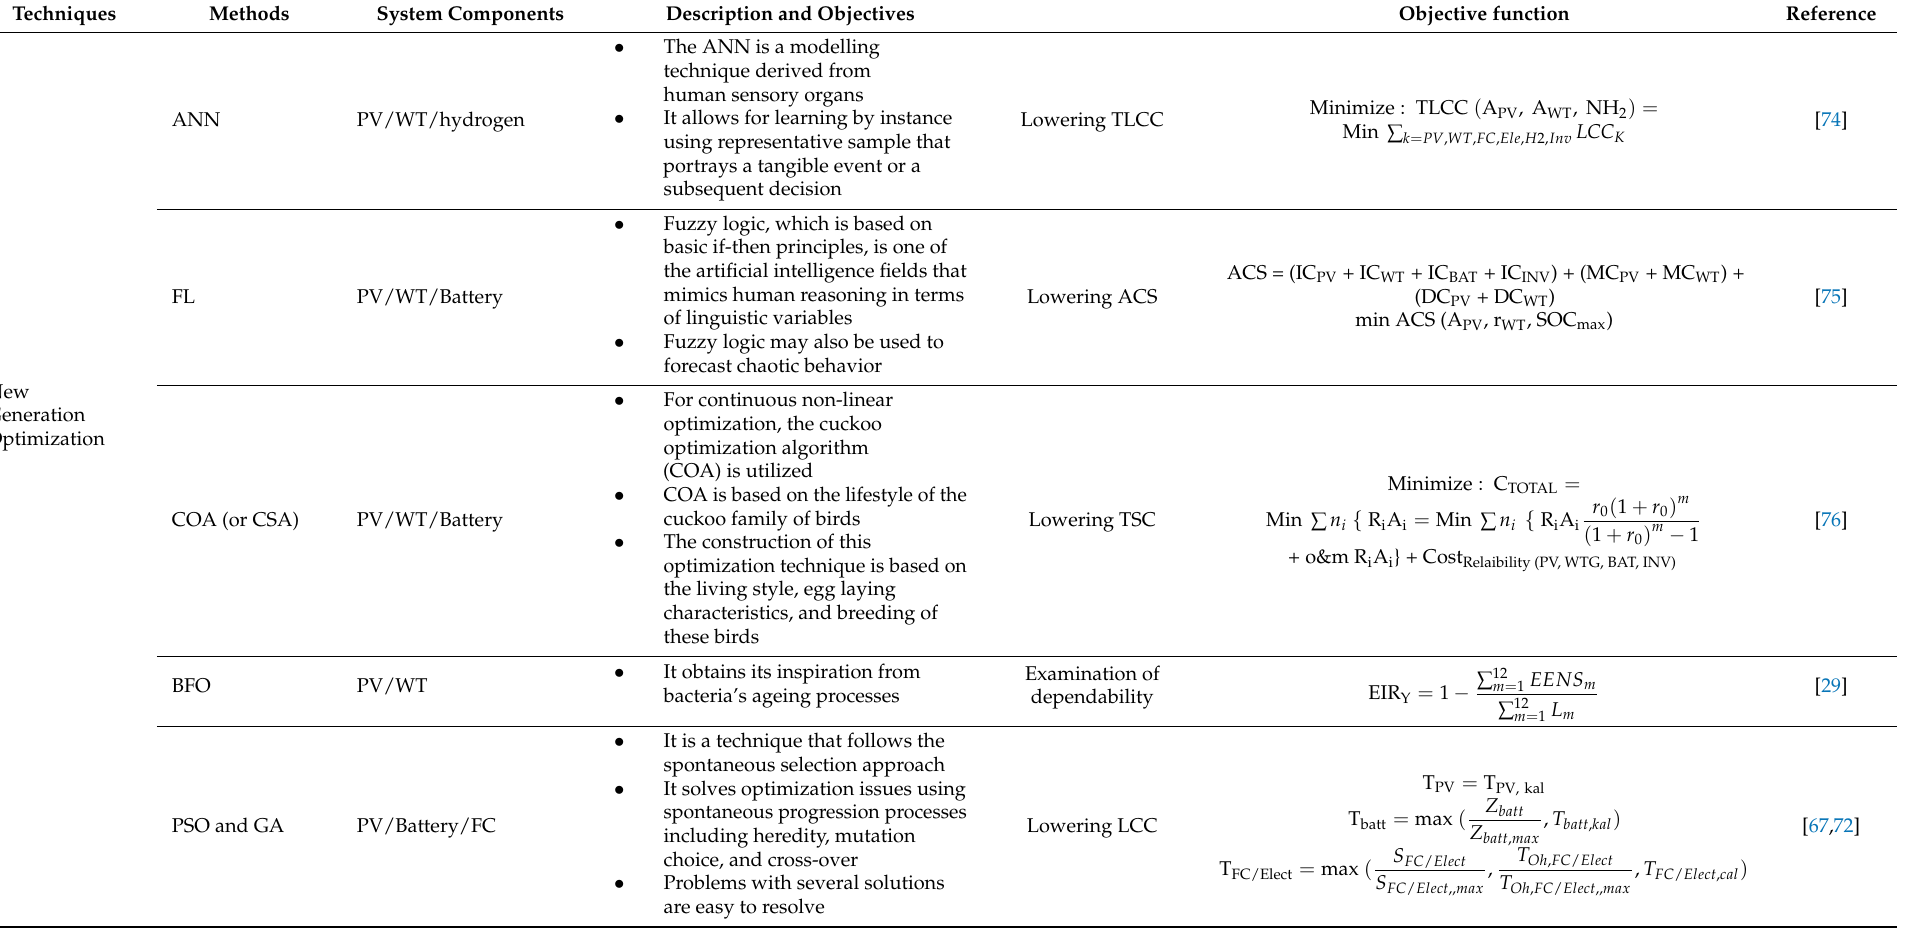
Table 3. A list of the new generation optimization